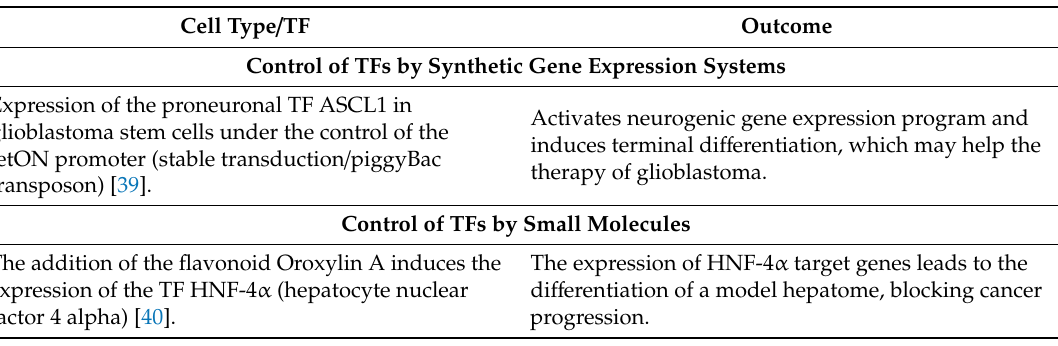
Table 2. Application of endogenous transcription factors